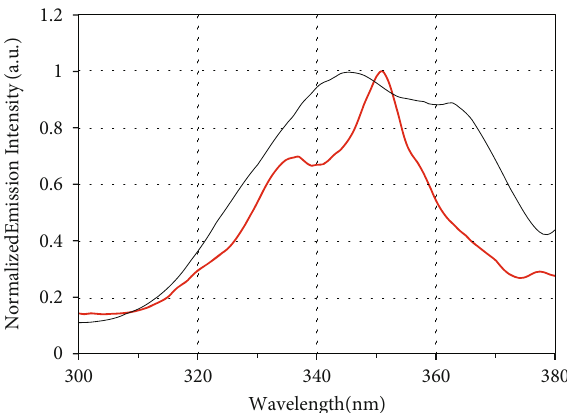
Figure 8: Normalized excitation spectra of the Pyr − /LDH hybrid fi lm monitored at 400 nm (red line) and 460 nm (black line).